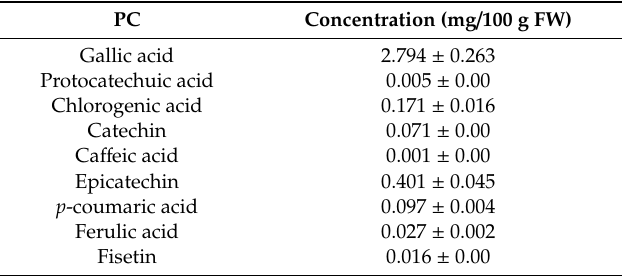
Table 3. The concentration of the 9 PCs in the persimmon extract.